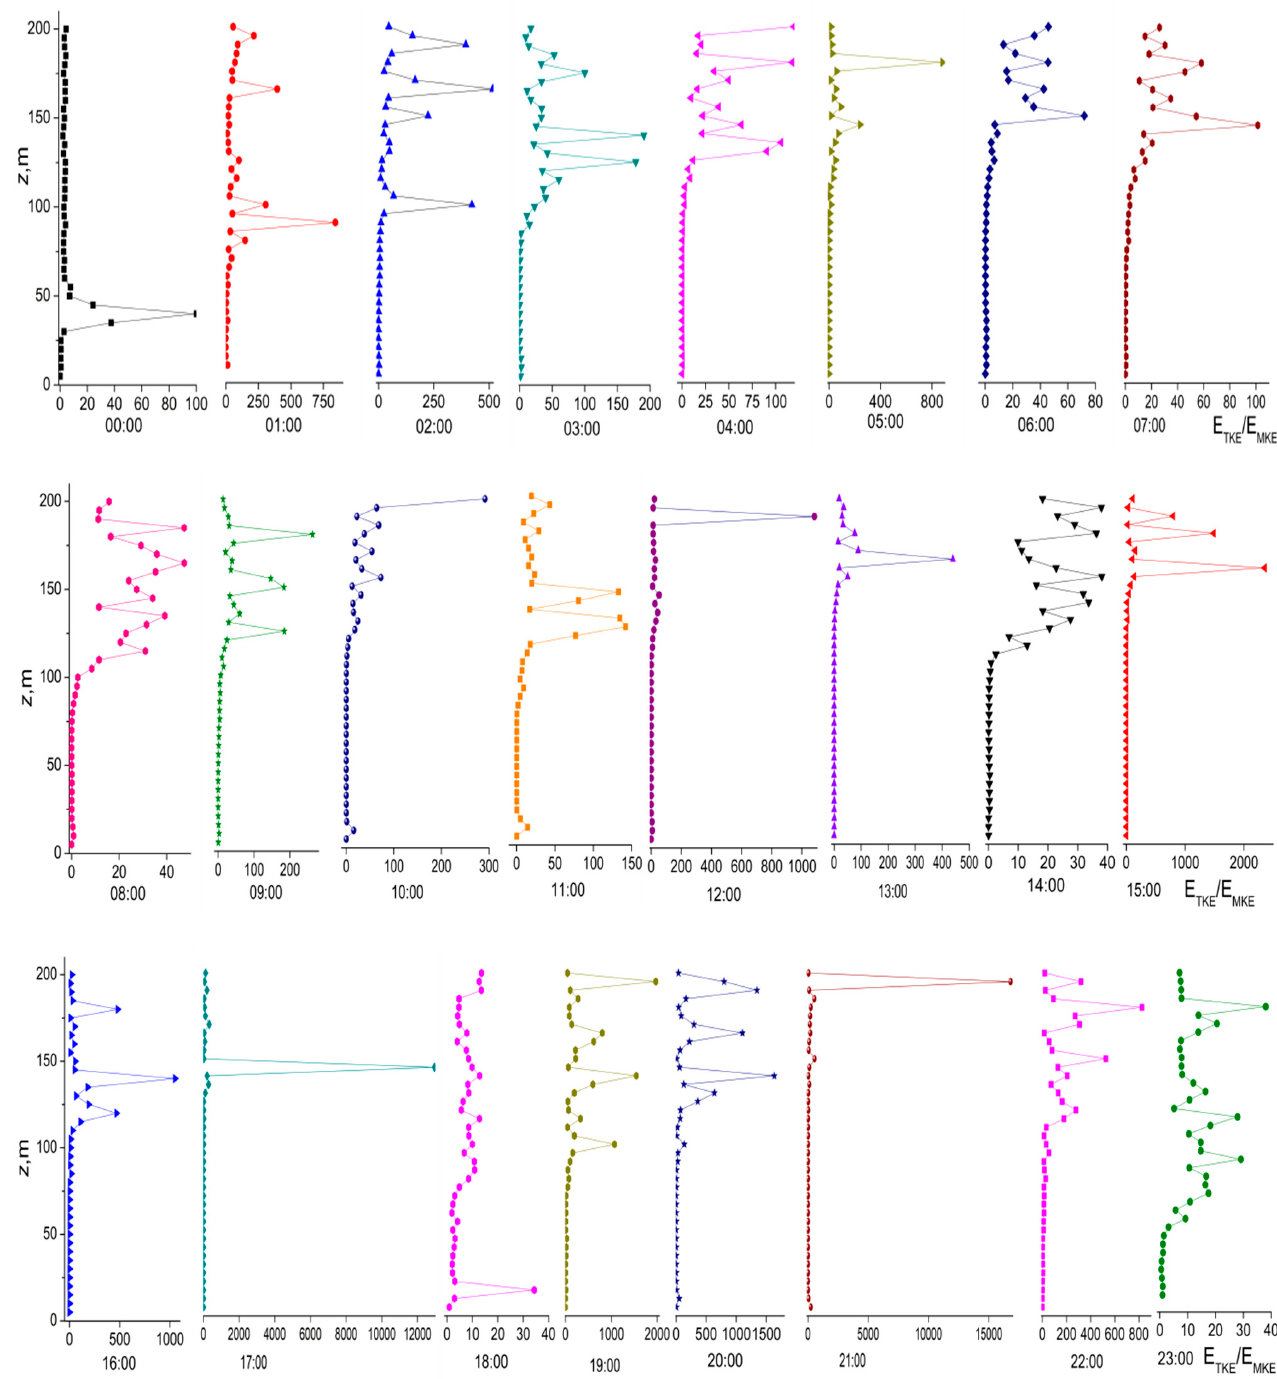
Figure 2. Diurnal hourly dynamics of the ratio of the turbulent to the mean kinetic wind energy components. Thus, starting from midnight during night and early morning hours, the lower boundary of the layer of enhanced turbulence changed from 40–50 m at 0:00 to 150 m at 07:00 with nonmonotonic variations of max from 800 at 05:00 to 40 at 08:00. In the morning (from 09:00 till 11:00), z 1 slightly increased, and δ max decreased from 300 to 150 . The situation changed at noon from 12:00 until 13:00. During this period, the thickness of the turbulent layer significantly decreased (down to 20–30 m), the height of its lower boundary z 1 considerably increased, and the δ max value reached 1000 at 12:00. This thin layer of strong turbulence is dangerous for UAVs and high rise buildings due to very high δ max values . However, it is promising for wind energy applications. At 14:00, δ max decreased down to 40, and the thickness of the turbulent layer increased from 125 to